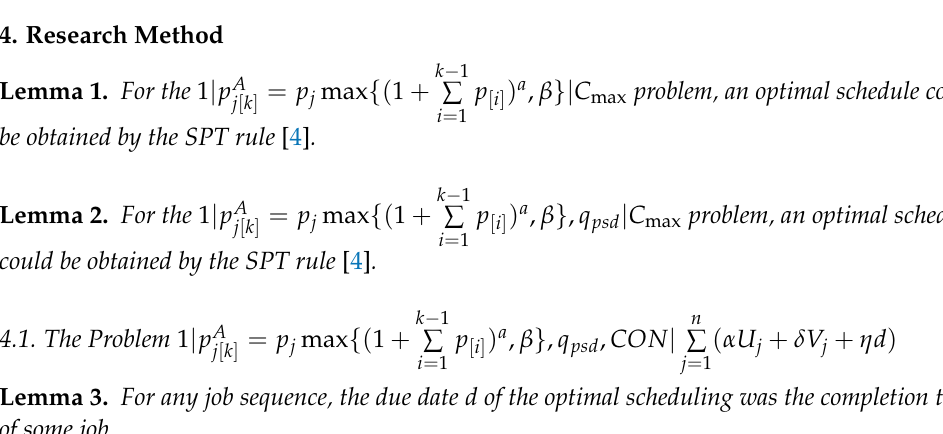
Figure 1. The just-in-time CON scheduling